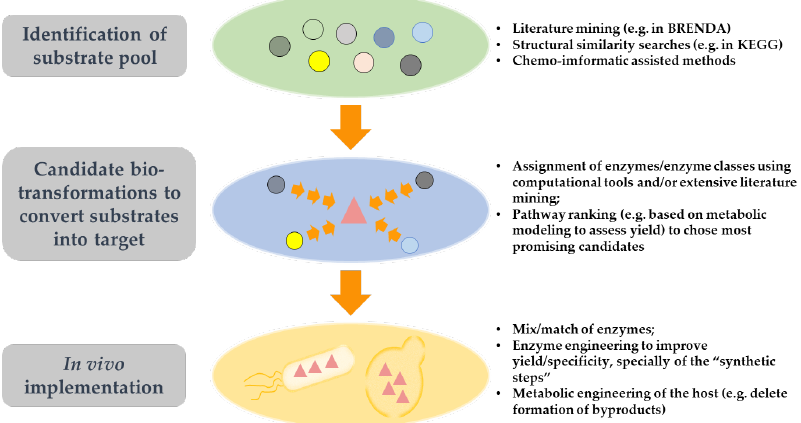
Figure 3. Schematic representation of a putative workflow that can be used to promote the prospection of new-to-nature pathways to enable the production of a non-natural compound in a microbial host of interest (in this case, S. cerevisiae and E. coli ).